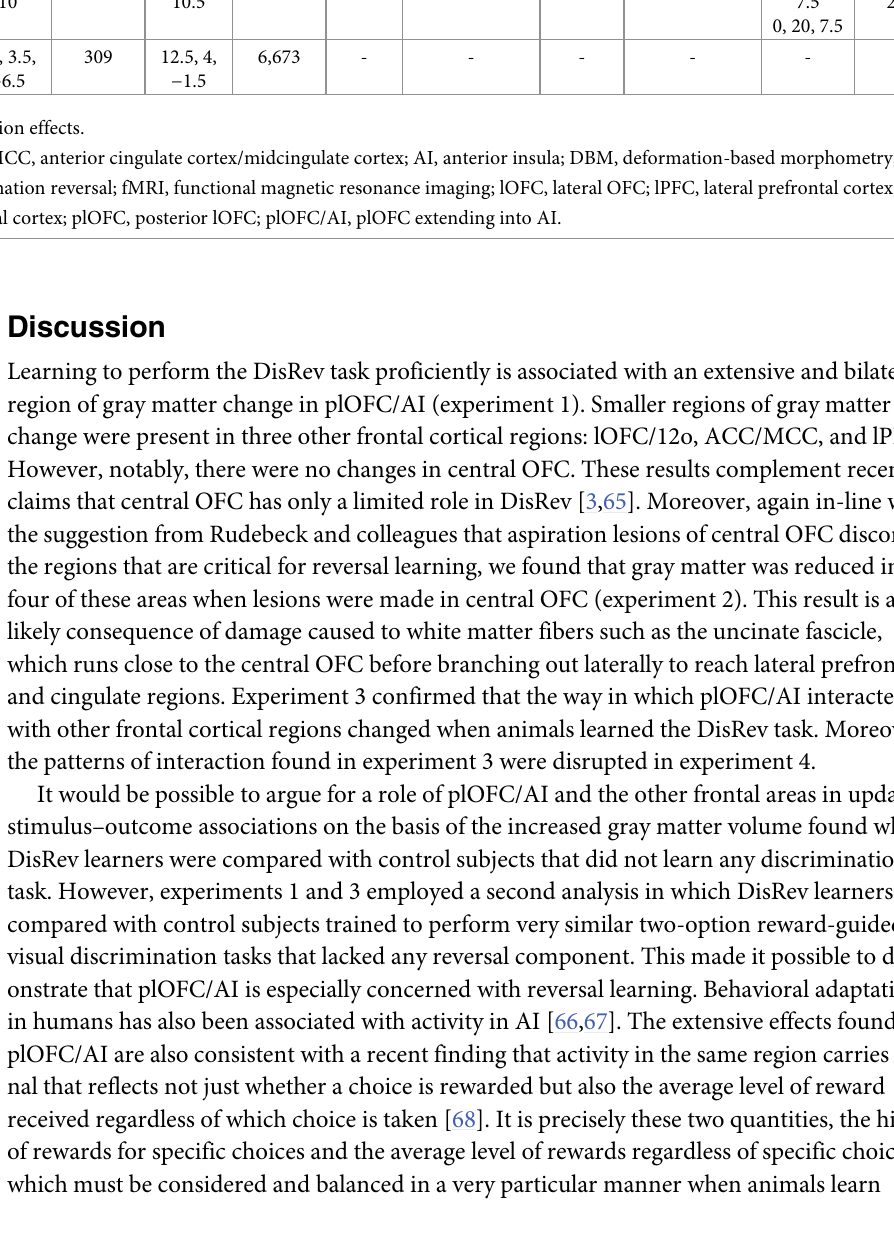
� All frontal regions fall within a large cluster of lesion effects. Abbreviations: 12o, orbital part of area 12; ACC/MCC, anterior cingulate cortex/midcingulate cortex; AI, anterior insula; DBM, deformation-based morphometry;